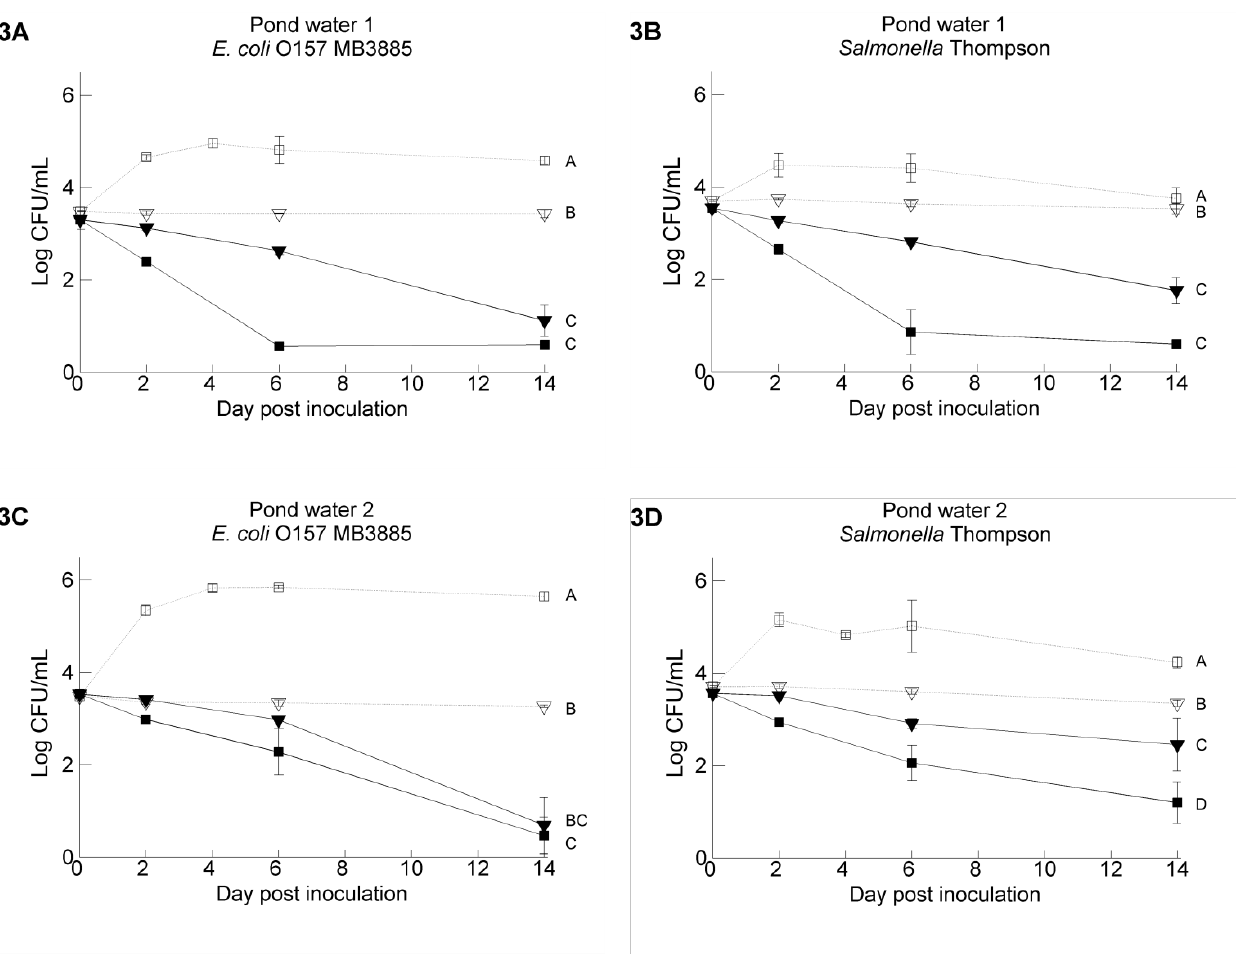
Figure 3. Survival of E. coli O157:H7 MB3885 ( left ) and Salmonella Thompson RM1987N ( right ) in two pond water samples with the following treatments: untreated water samples stored at 4 °C (full line,  ), filter sterilized water samples stored at 4 °C (dashed line,  ), untreated water samples stored at 20 °C (full line,  ), filter sterilized water samples stored at 20 °C (dashed line,  ). The data show the mean of three analyzed vials and are calculated from the log transformed values of the pathogen population size. Error bars indicate standard deviations. Different letters indicate significant difference ( p < 0.05) between means according to negative binomial